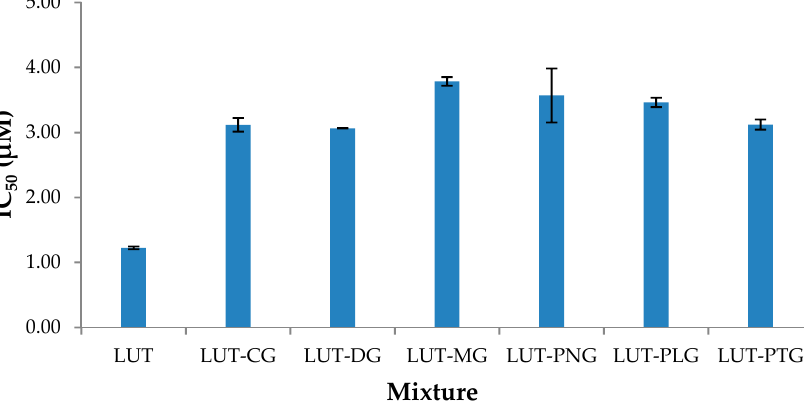
Figure 2. Lipoxygenase IC 50 of lutein alone and different lutein-anthocyanin combinations. IC 50 : inhibitory concentration that exerts 50% enzyme inhibition. LUT: lutein, CG: kuromanin chloride, DG: myrtillin chloride, MG: oenin chloride, PNG: peonidin-3-glucoside chloride, PLG: callistephin chloride, PTG: petunidin-3-glucoside chloride.